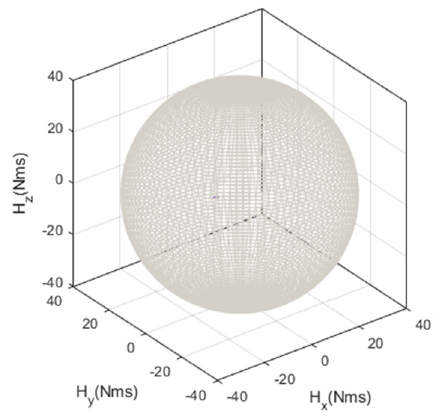
Figure 21. Momentum history for Scenario 1.